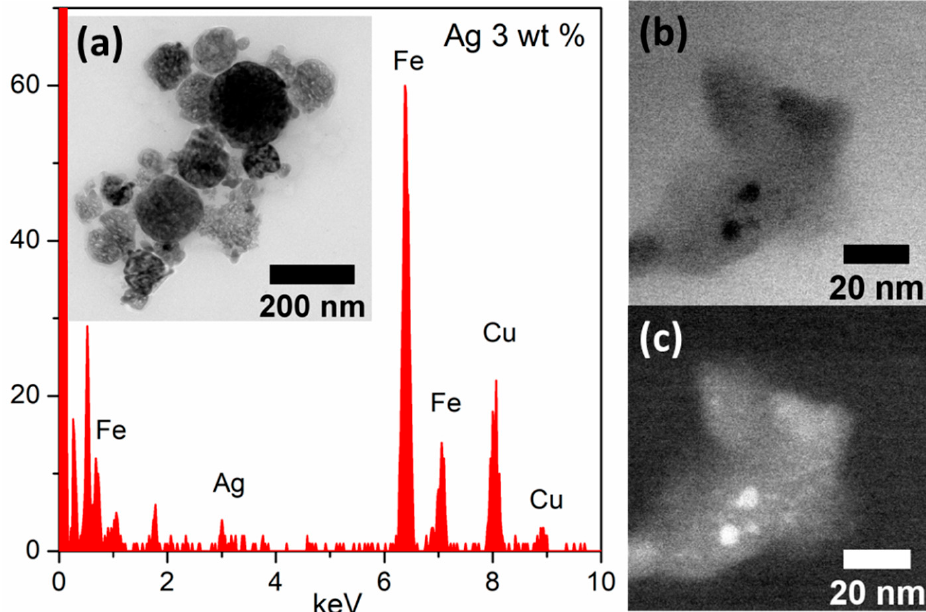
Figure 3. ( a ) TEM image of spheroidal nanoparticle of α -Fe2O3/Ag at 3 wt% and TEM-EDX spec- tra. ( b ) BF-STEM (bright-field-scanning transmission electron microscopy) and ( c ) high-angle